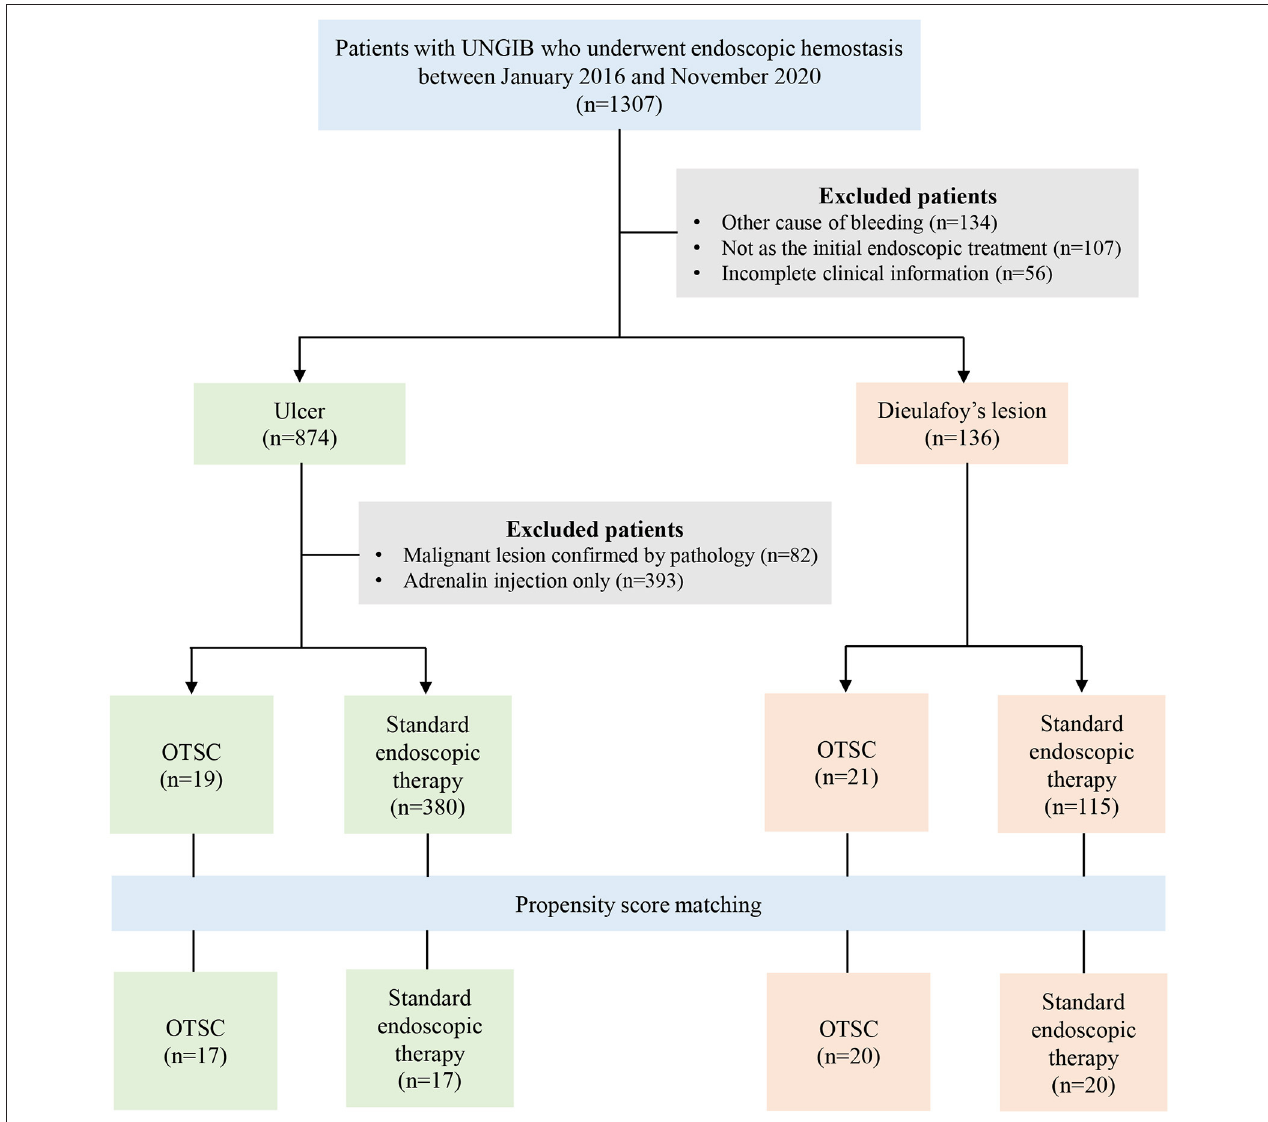
FIGURE 1 | A flowchart of the study cohort in patients with